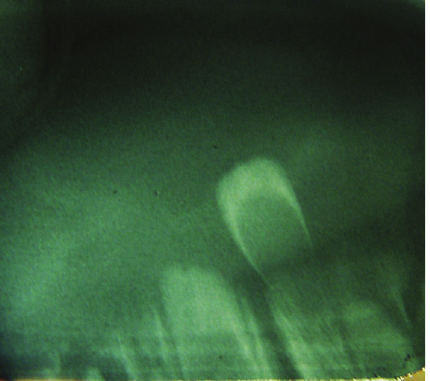
Figure 2: Periapical radiograph showing the natal tooth in the mandibular anterior